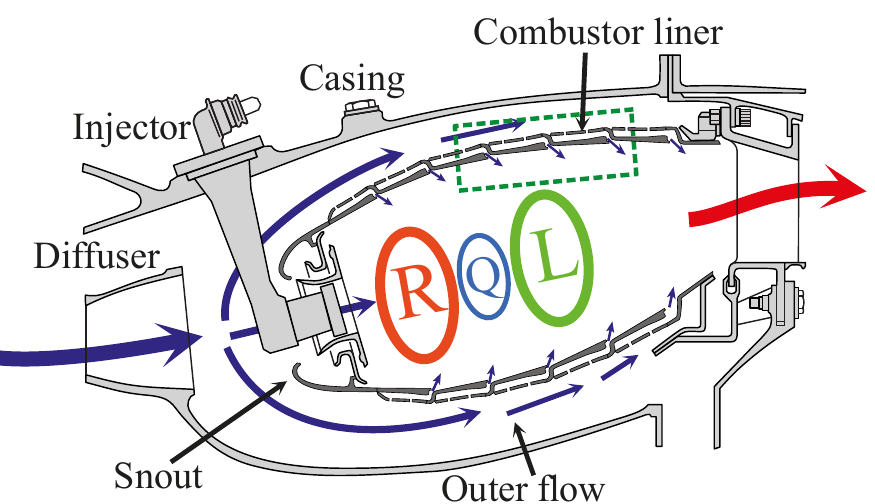
Figure 1. Double-Wall design study adapted from V2500 combustor. The compressed air (blue) is divided between combustor liner and outer flow. The air in the outer flow acts as mixing air and coolant, while the combustor liner air is used for primary combustion (red). Green area marks the region of interest for this